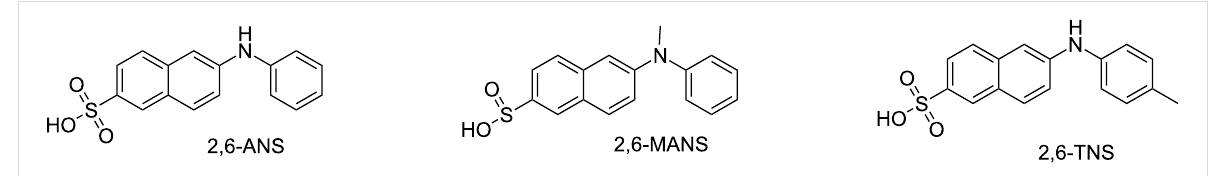
Figure 2: Structure of fluorescent guest molecule, 2,6-ANS, used to probe host–guest interaction and two derivatives thereof with methyl substitu- tions at the anilino moiety.